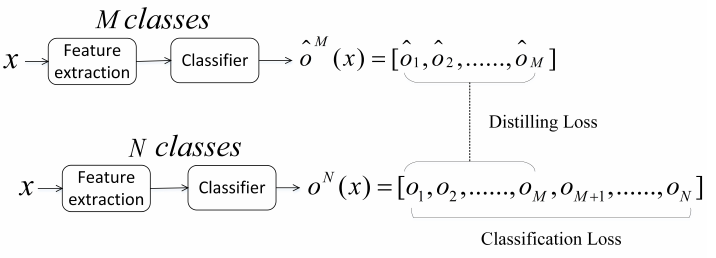
Figure 4. The diagram of distillation loss and classification loss. The distillation loss is used on old classes, while the classification loss is used on all old and new